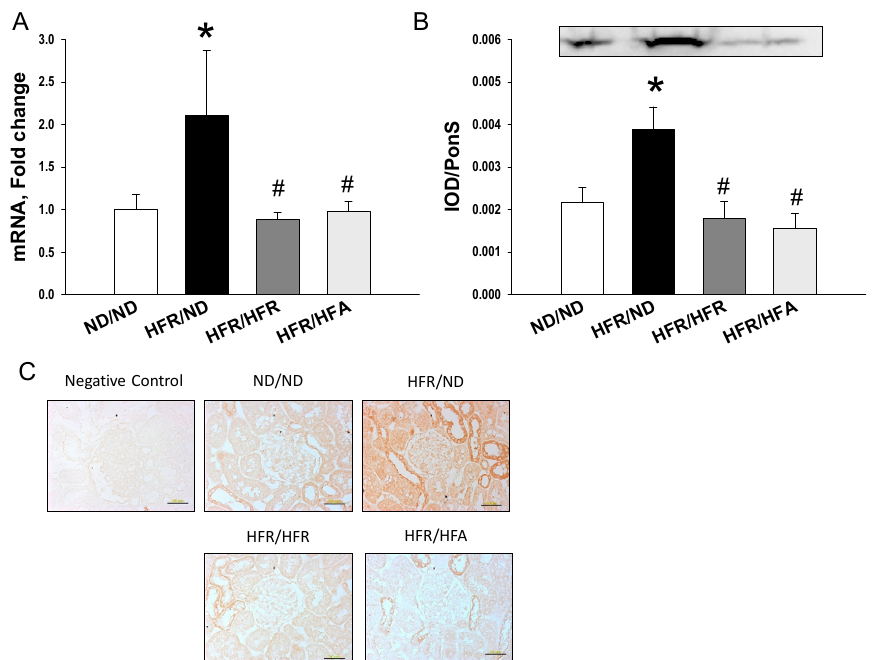
Figure 5. Effect of maternal and post-weaning high-fructose (HFR) and post-weaning high-fat (HFA) intake on mRNA expression of ( A ) Ephx2 and ( B ) soluble epoxide hydrolase (SEH) protein (62 kDa); and ( C ) light micrographs illustrating immunostaining for SEH in the kidney in male offspring at 12 weeks of age. Bar = 50 μ m. n = 8/group; * p < 0.05 vs. ND/ND; # p < 0.05 vs. HFR/ND.